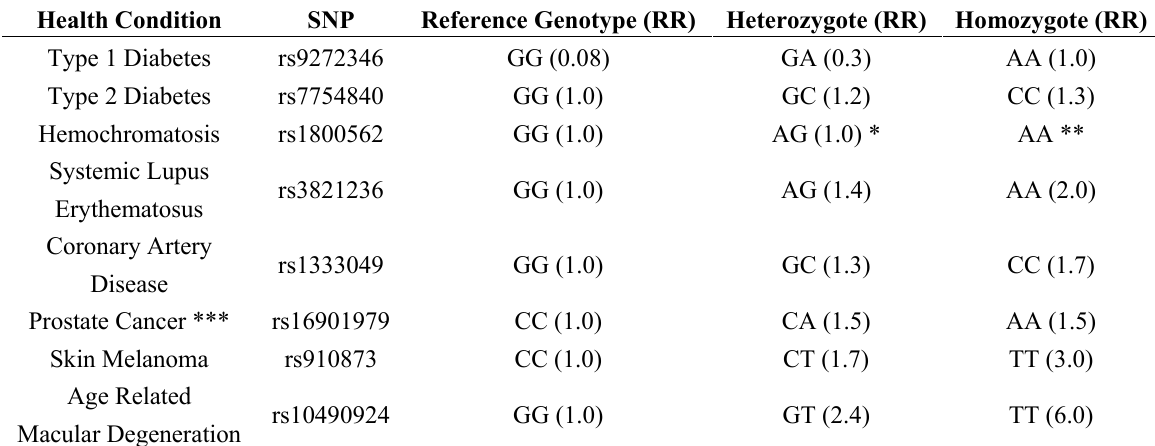
Table 1. Initial results: health conditions and relative risk based on SNP variant